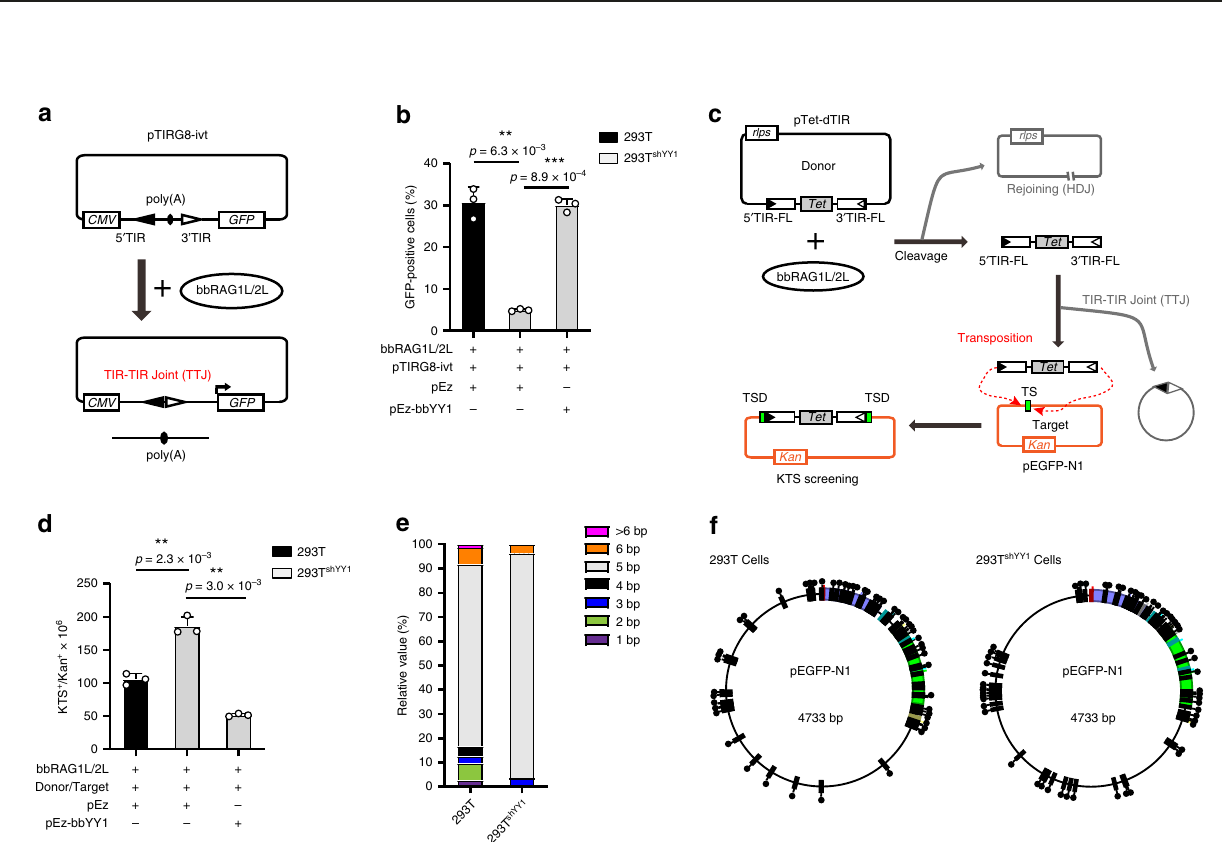
Fig. 4 BbYY1 contributes to precise TIR ends (TIREs) by aiding the recognition of appropriate TIRs. a Illustration of the LM-PCR method for detecting cleavage sites of TIR substrate after bbRAG1L/2L-mediated recombination. Right TIRE happened when cleavages occurred at the borders of both 5 ′ and 3 ′ TIRs, while short TIRE happened when cleavages occurred between the 5 ′ and 3 ′ TIRs. P5, P6, and P7 indicate speci fi c PCR primers. The adapter and these primers are listed in Supplementary Table 1. b , c The upper gels show that fewer and shorter TIREs occurred after TIR-dependent recombination in 293T shYY1 cells. sTIRE, short TIR ends. The lower gels show the expression of the normalized control gene (Kanamycin resistance gene, indicated as Kan ) on pTIR104. LM-PCRs were performed using rTaq DNA polymerase with 30 cycles ( b ) or KOD plus neo DNA polymerase with 45 cycles ( c ). The representative LM-PCR gels represent three independent duplications. For more details regarding the PCR procedures, see the Methods section. d Alignment of 5 ′ TIREs after TIR-dependent cleavage in 293T shYY1 cells showed a broad range of imprecise cleavage, indicating the formation of group 1 imprecise HDJs in 293T shYY1 cells. e Schematic diagram illustration of different TIR signal recognition mediated by bbRAG1L/2L in vivo. The recognition and cleavage occurring between sites 1 and 2 or between sites 1 and 3 would lead to GFP or mCherry expression, respectively. f Percentage of GFP- and mCherry-positive cells after bbRAG1L/2L-mediated recombination in 293T and 293T shYY1 cells using the pSel G-mCh construct as e indicated. The values represent the means ± s.d., with n = 3 biologically independent experiments. A two-tailed, unpaired Student ’ s t test was used for comparisons. * P < 0.05; ** P < 0.01; *** P < 0.001; **** P < 0.0001. ns, not signi fi cant. See also Supplementary Fig. 4E. g The DNA pulldown assay showed that greater abundances of bbRAG1L/2 L and bbYY1 were pulled down by the WT 5 ′ TIR (bio-5 ′ TIR) but not the TR5-mutated 5 ′ TIR (bio-5 ′ TIR-Mu) in the presence of increasing poly dA:dT. The blots represent three independent duplications. For b , c , f , and g , source data are provided as Source Data fi le.